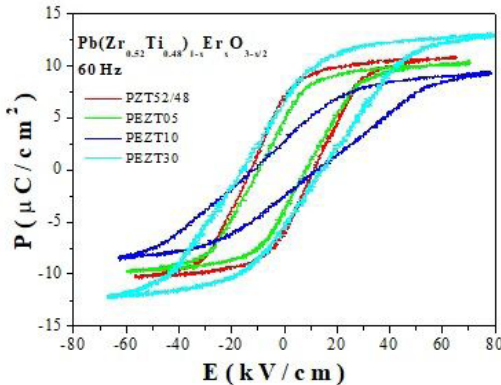
Figure 11. Room temperature P – E hysteresis loop of PZT and PEZT at 60 Hz for x = 0.0, x = 0.5, x = 1.0, and x =